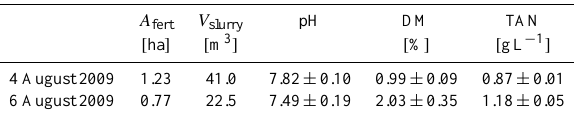
Table 2. Slurry properties; A fert =fertilised area, V slurry =volume of applied slurry, DM=dry matter content, TAN=total ammoniacal nitrogen.